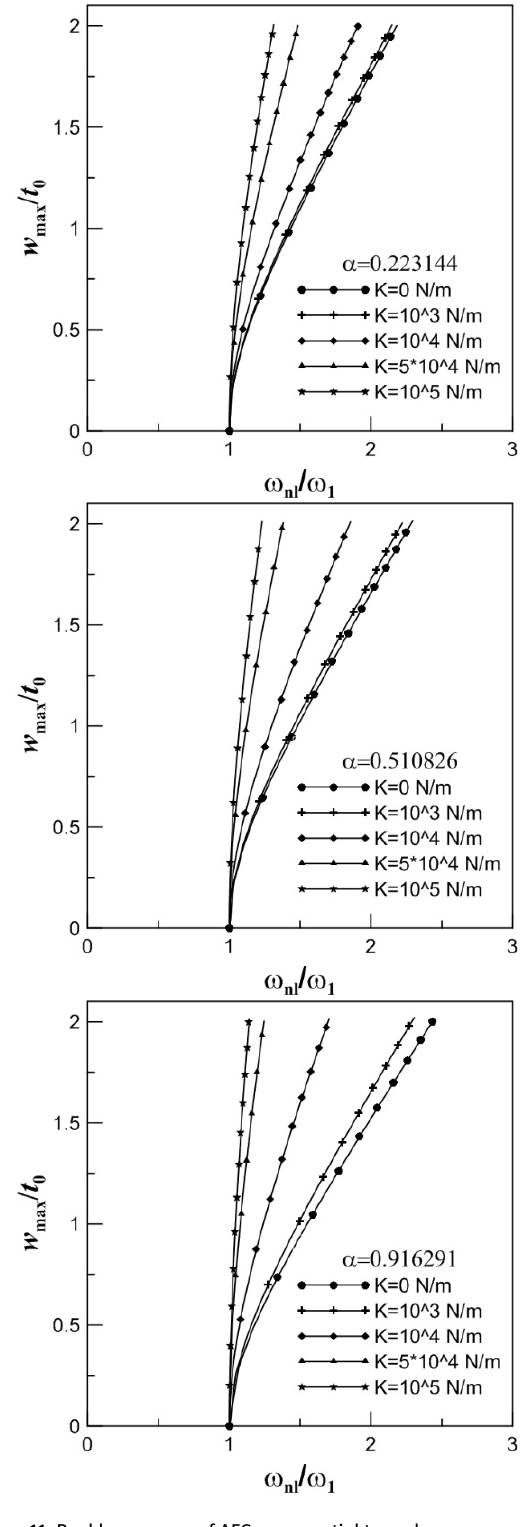
Figure 10: Backbone curve of AFG exponential taper beam (︀ E ( ξ ) = E (︀ 1 + ξ + ξ 2 )︀)︀ on elastic foundation. 0 (1 + ξ ) , ρ ( ξ ) = ρ 0